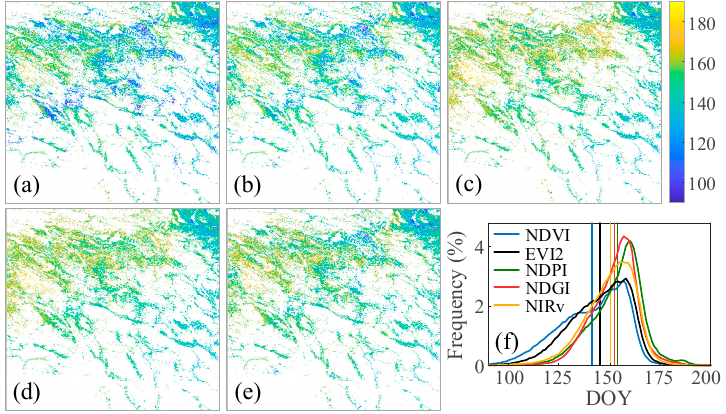
Figure 8. The SOS detected by ( a ) NDVI, ( b ) EVI2, ( c ) NDPI, ( d ) NDGI, ( e ) NIRV, and ( f ) the corresponding histograms for 2020.